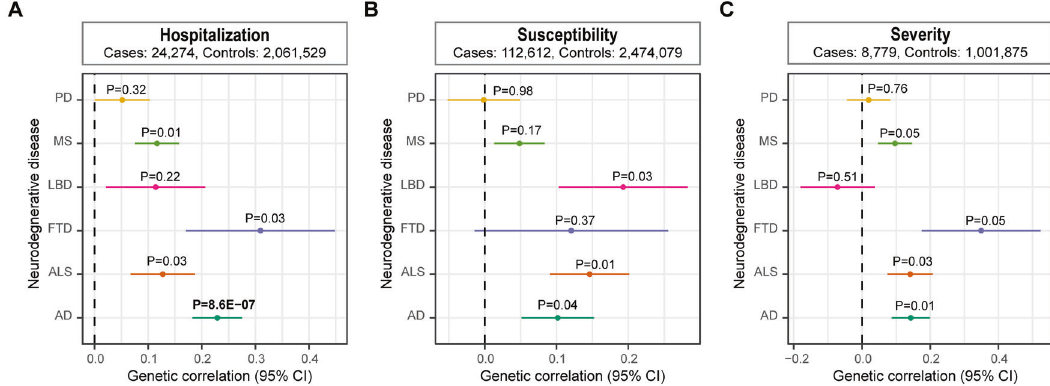
Fig. 1 Forest plot showing results from the genetic correlation analysis. Genetic correlation between A hospitalization, B susceptibility, C severity of COVID-19 and neurodegenerative disorders. Error bars indicate 95% con fi dence intervals. Bold P value denotes statistical signi fi cance after the Bonferroni